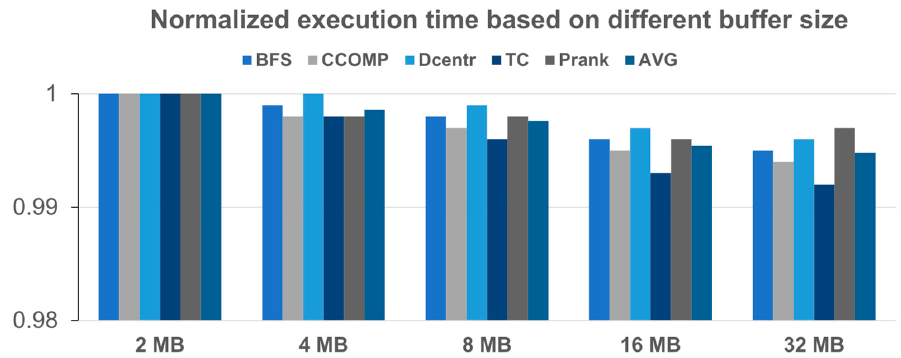
Figure 8. Execution time for different buffer sizes.